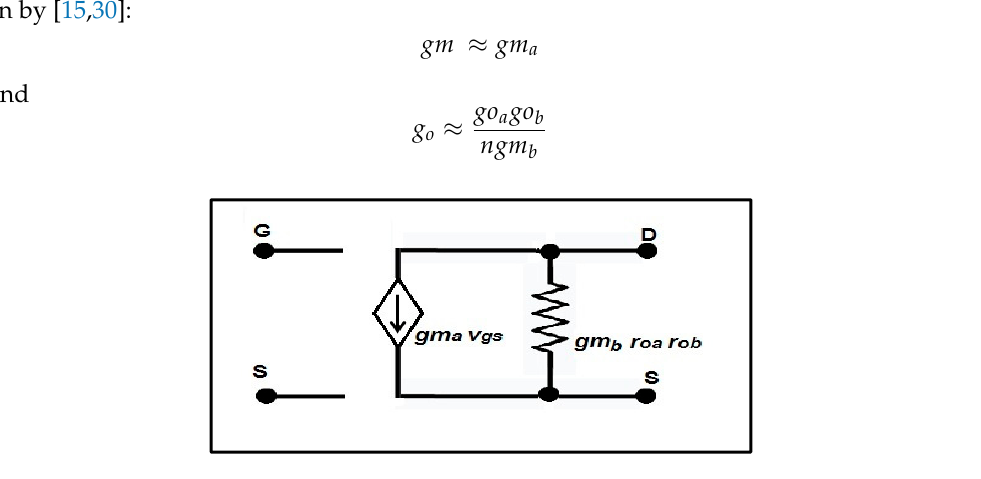
Figure 6. Small signal model of the composite transistor.